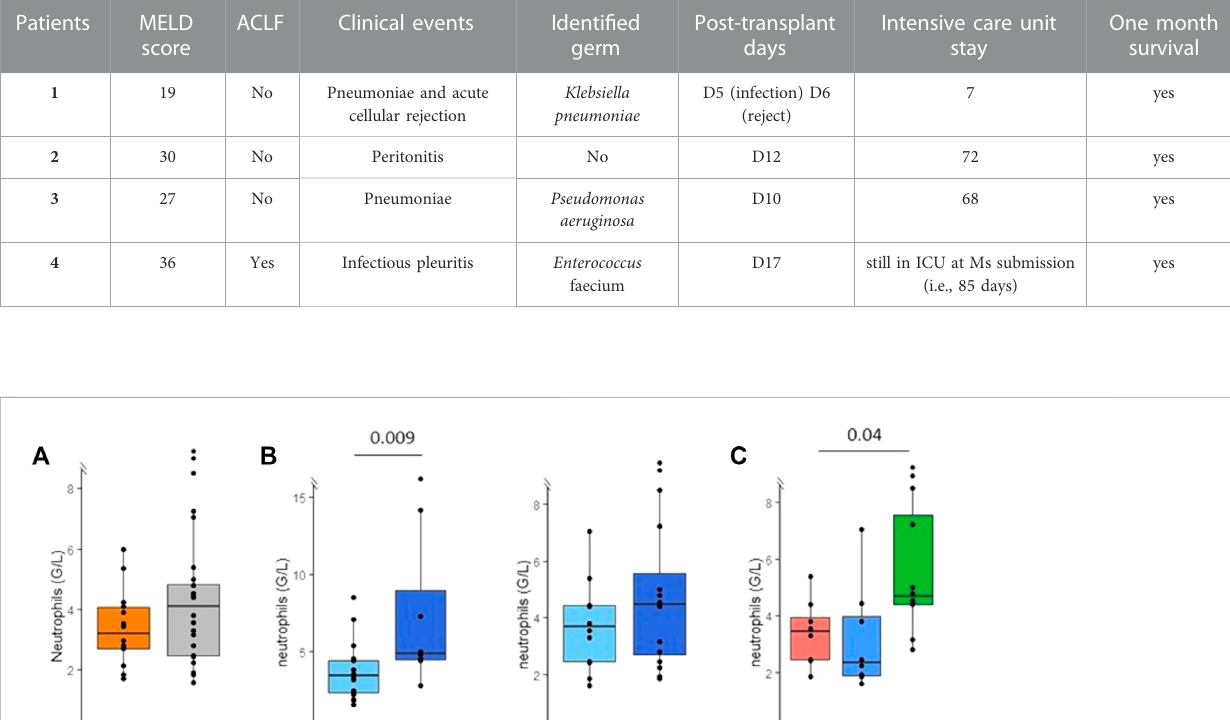
TABLE 3 Infectious and graft rejection outcomes.